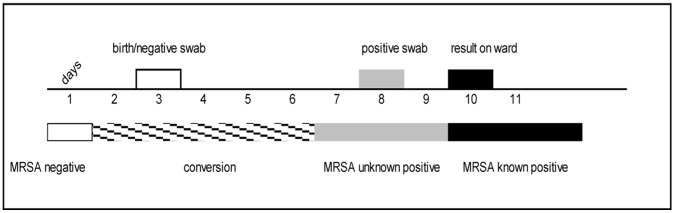
Definition of MRSA-related patient status.Initially, birth or a negative swab result in the status “MRSA-negative”. A few days later another swab is taken, which turns out MRSA-positive. MRSA is presumed to have been acquired latest one day before the positive swab was taken, because it takes time for the bacteria to multiply and spread from the location of transmission to the location being swabbed. Therefore, the infant’s status is “unknown MRSA-positive” from one day before the positive swab until the positive result is received on the ward. Thereafter, the infant’s status is “known MRSA-positive”.